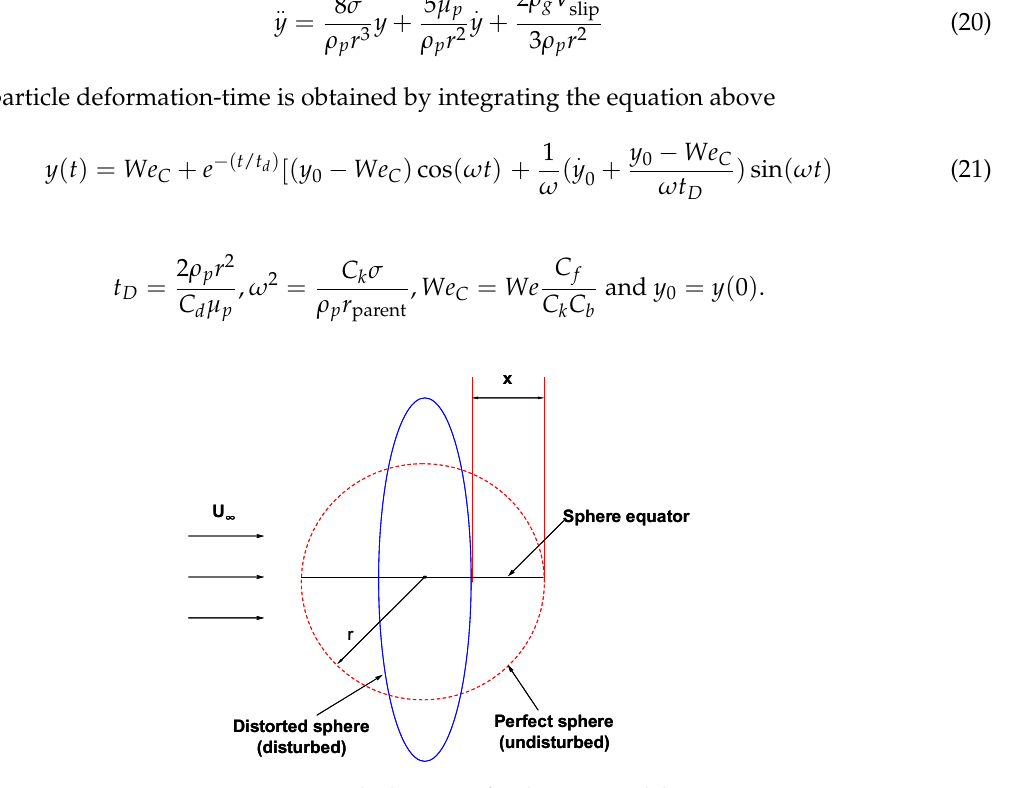
Figure 2. Particle distortion for the TAB model.